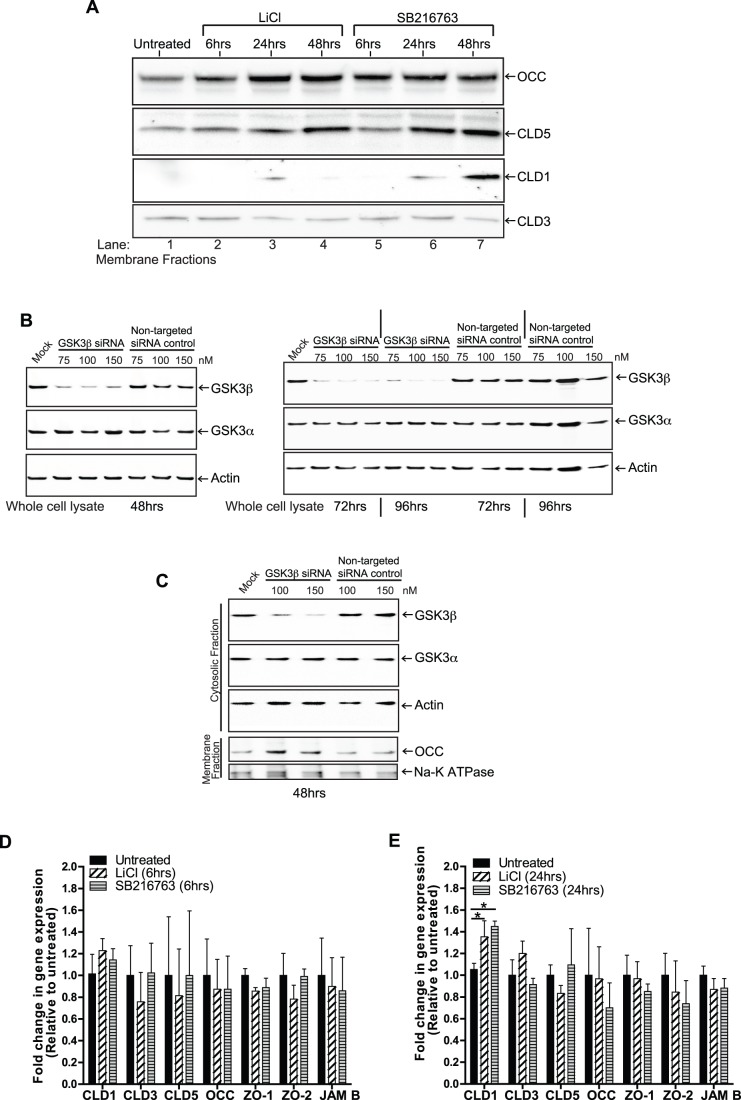
GSK3β inhibition regulates the presence of tight junction proteins in BMVEC membrane fractions.(A) Western blots of BMVEC membrane fractions from cells treated for 6, 24 and 48 hr with GSK3β inhibitors LiCl (10 mM) and SB216763 (20 µM). Except for claudin-3 (CLD3), the levels of occludin (OCC), claudin-1 (CLD1) and claudin-5 (CLD5) increased in response to the GSK3β inhibitors. (B, C) Western blot analysis of BMVEC cell lysates (B) and cellular fractions (C) after transfection with no siRNA (mock), non-targeted and GSK3β targeting siRNAs. Efficient knock-down of GSK3β, and not GSK3α, resulted in increased levels of occludin (C). Note: actin and the Na-K ATPase were used as loading controls. (D and E) Total RNA was extracted from BMVEC (treated as described in panel A) and the mRNA levels of the indicated genes were determined by quantitative PCR at (D) 6 hr and (E) 24 hr. The housekeeping genes, GAPDH and RPLP0, were used as endogenous internal reference genes. The data was analyzed using the ΔΔCt method and the results are expressed as relative gene expression levels (fold regulation) comparing the treated with the untreated control. The results are shown as the average+SD fold regulation from three different BMVEC donors.